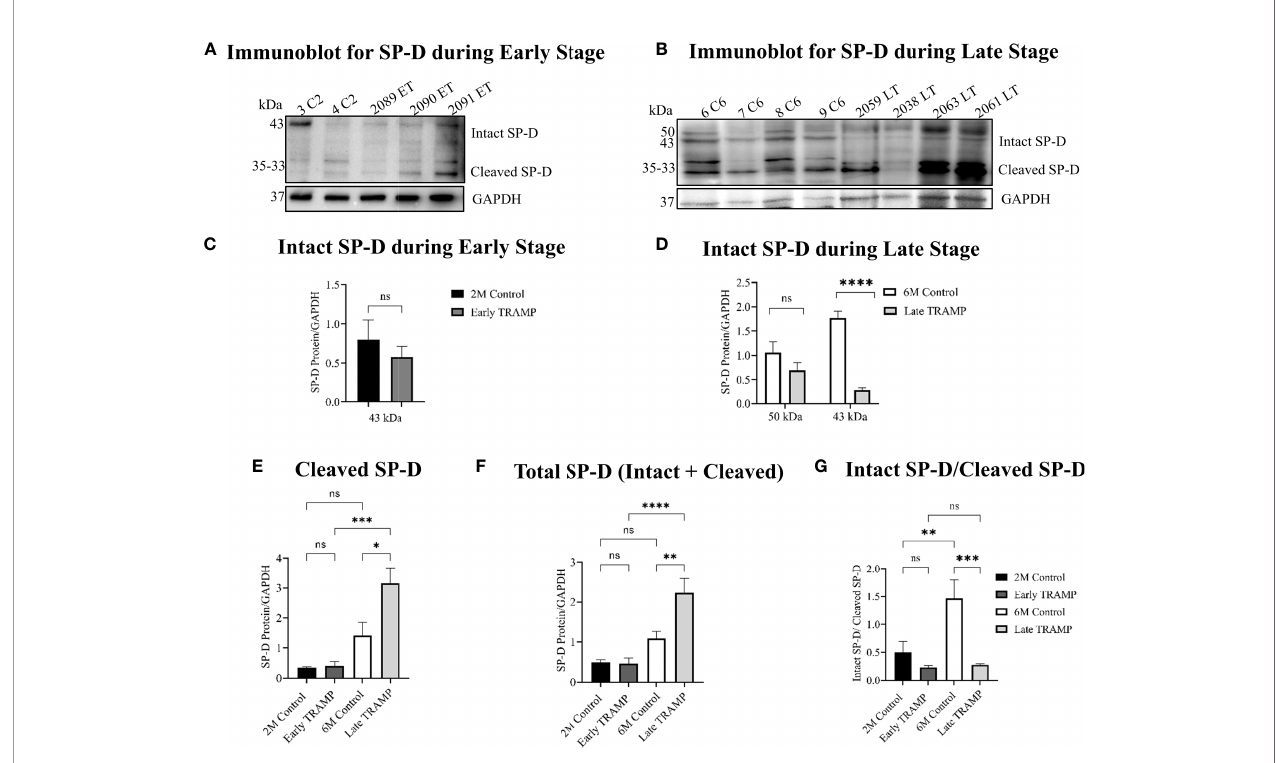
FIGURE 3 | Impairedexpression of the intact formof SP-D throughout the tumour progression.Total protein lysates were analysedby Westernblot for SP-D and GAPDH. (A) Immunoblot analyses of intact monomeric formofSP-D (~45kDa) andcleaved SP-D fragments (~35kDa-~33kDa) inthe Early TRAMPcompared with the corresponding 2M controls. C2: 2MControl mice; ET: Early TRAMP; 3 C2: 2M Control miceno. 3; 4 C2: 2M Control mice no. 4; 2089 ET: Early TRAMPmice no. 2089; 2090 ET: Early TRAMPmice no. 2090; 2091 ET: Early TRAMP mice no. 2091. (B) Immunoblot analyses of intact monomeric form of SP-D (~43kDa), differentially glycosylated formofSP-D (~50kDa) and cleaved SP-D fragments (~35kDa-~33kDa) in the Late TRAMP, compared with thecorresponding 6M controls. C6: 6MControl mice; LT: Late TRAMP; 6 C6: 6M Control mice no. 6; 7 C6: 6M Controlmice no. 7; 8 C6: 6M Control mice no. 8; 9 C6: 6M Control mice no. 9; 2059 LT: Late TRAMPmiceno. 2059; 2038 LT: Late TRAMPmice no. 2038; 2063 LT: Late TRAMP mice no. 2063; 2061 LT: Late TRAMPmice no. 2061. GAPDHwas used as a loadingcontrol. (C – G) Densitometric analysis of proteins normalized with GAPDH. n=3-6 for each group. Data are represented as mean ± SEM. Statistical signi fi cance was determined using two-tailed Student ’ s t-test (C) ; one-way ANOVA followedTukey ’ s multiplecomparisons test (D – G) , NS, Non-signi fi cant. (*p < 0.05, **p < 0.01, ***p < 0.001, ****p <